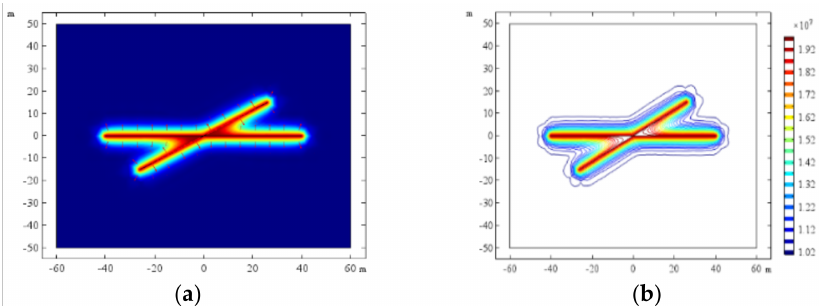
Figure 8. Case 5 calculation result. ( a ) Grout propagation pattern. ( b ) Distribution of grout propaga- tion pressure